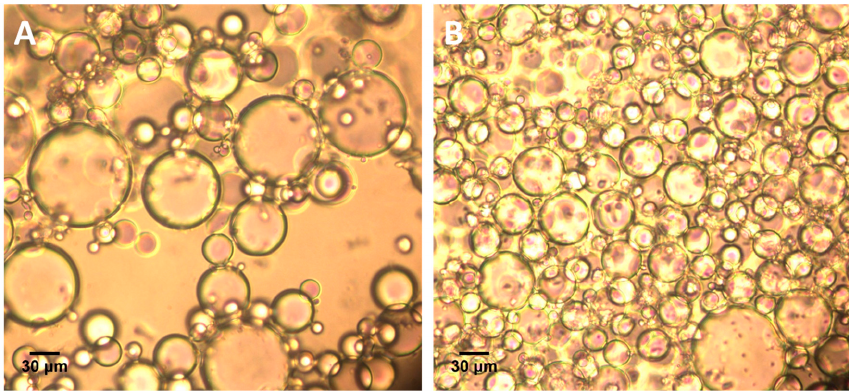
Figure 1. Optical microscope image of prepared Pickering emulsion with different H 30 concentrations: ( A ) 1 w/v % of H 30 silica particles, sample P 0.02-0.1-2 ; ( B ) 2 w/v % of H 30 silica particles, sample P 0.04-0.1-2 .